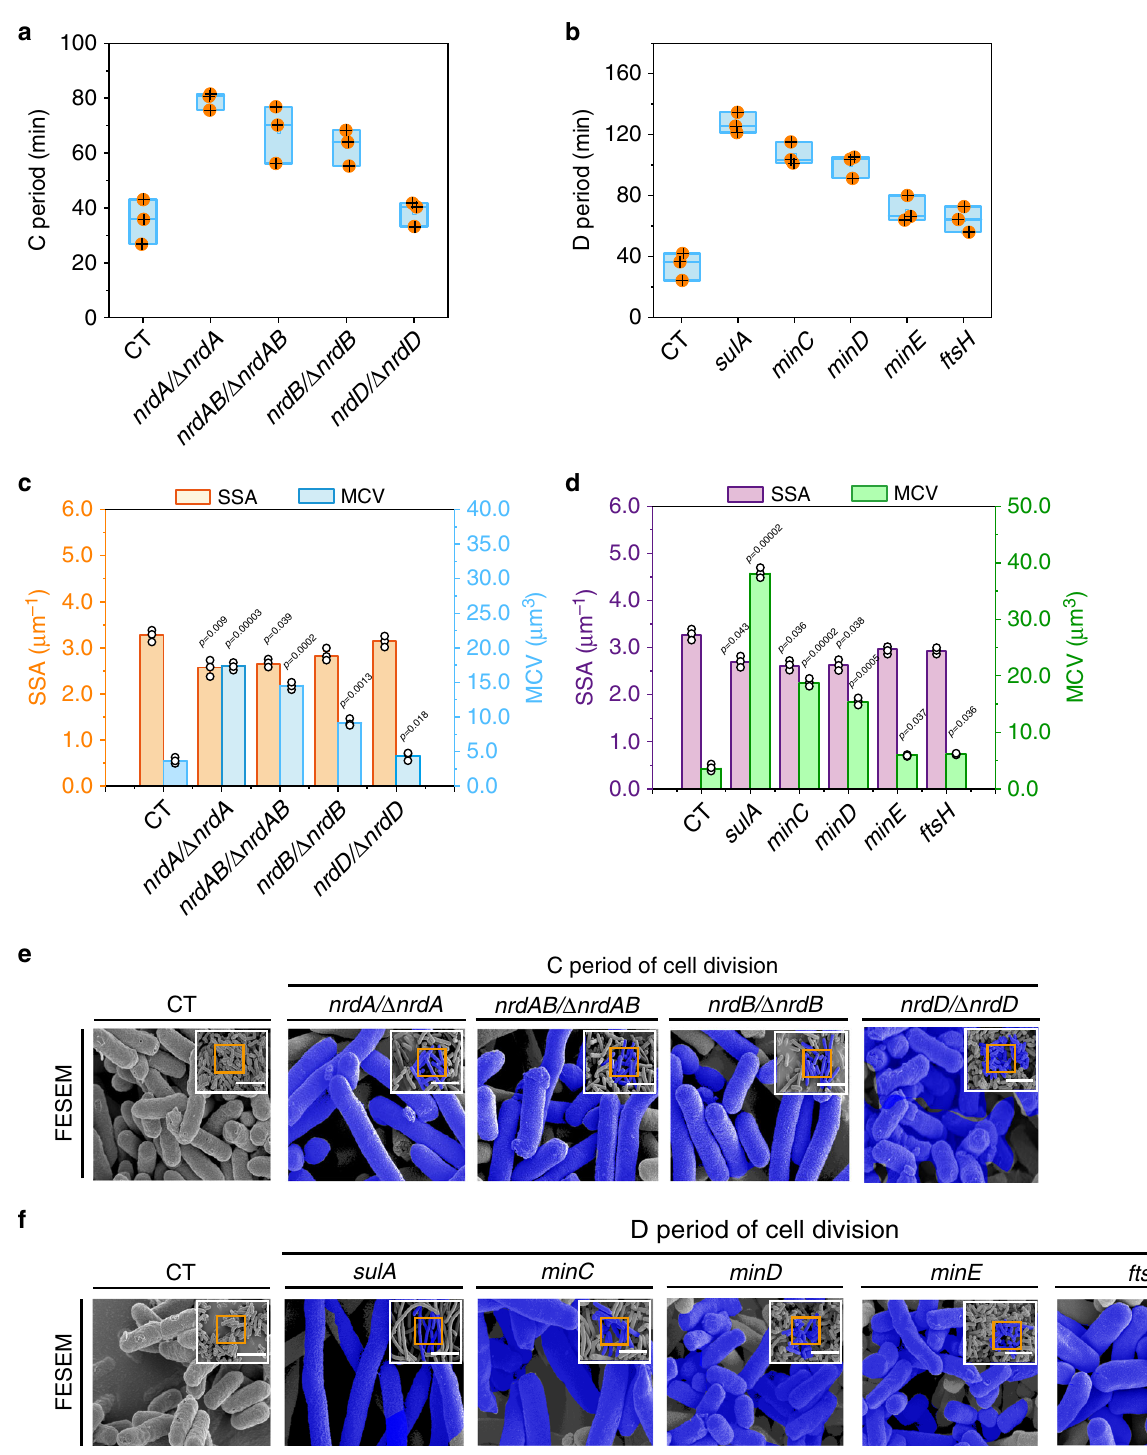
Fig. 2 Prolonging the C and D periods of cell division by genetic manipulation. a , b Effect of prolonging the C and D periods of cell division on cell division. c , d Effect of prolonging the C and D periods of cell division on the speci fi c surface area (SSA) and mean cell volume (MCV). e , f Con fi rming the morphological variations of the all engineered strains by the FESEM. The blue color of FESEM was highlighted. For the original pictures were shrinked into the top right corner of the enlarged pictures. In nrdA/ Δ nrdA , nrdAB/ Δ nrdAB , nrdB / Δ nrdB , and nrdD/ Δ nrdD mutants, nrdA , nrdAB , nrdB , and nrdD were weakly expressed by low concentration IPTG (10 μ M), respectively. a , b The box plots de fi ne the minima, maxima, center, and bounds of box. e , f The scale bar is 5 μ m. Signi fi cance ( p -value) was evaluated by two-sided t -test, compared to CT. a – d Values are shown as mean ± s.d. from three ( n = 3) biological independent replicates. Information for each gene was provided in Supplementary Note 1. Source data are provided as a Source data fi